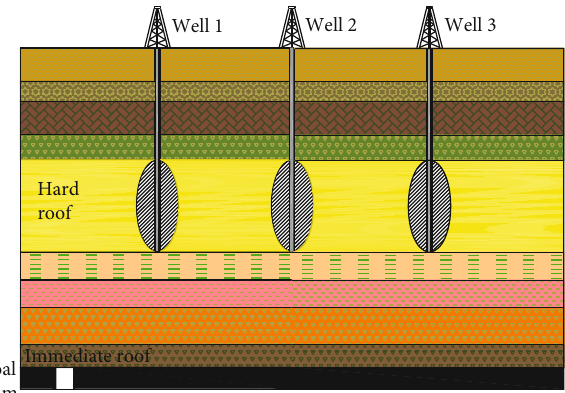
Figure 5: Schematic of the ground fracturing